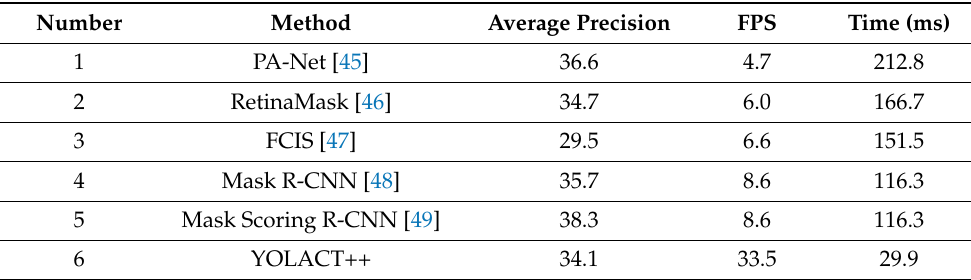
Table 2. Segmentation experiment results of different types of instance segmentation networks on the COCO